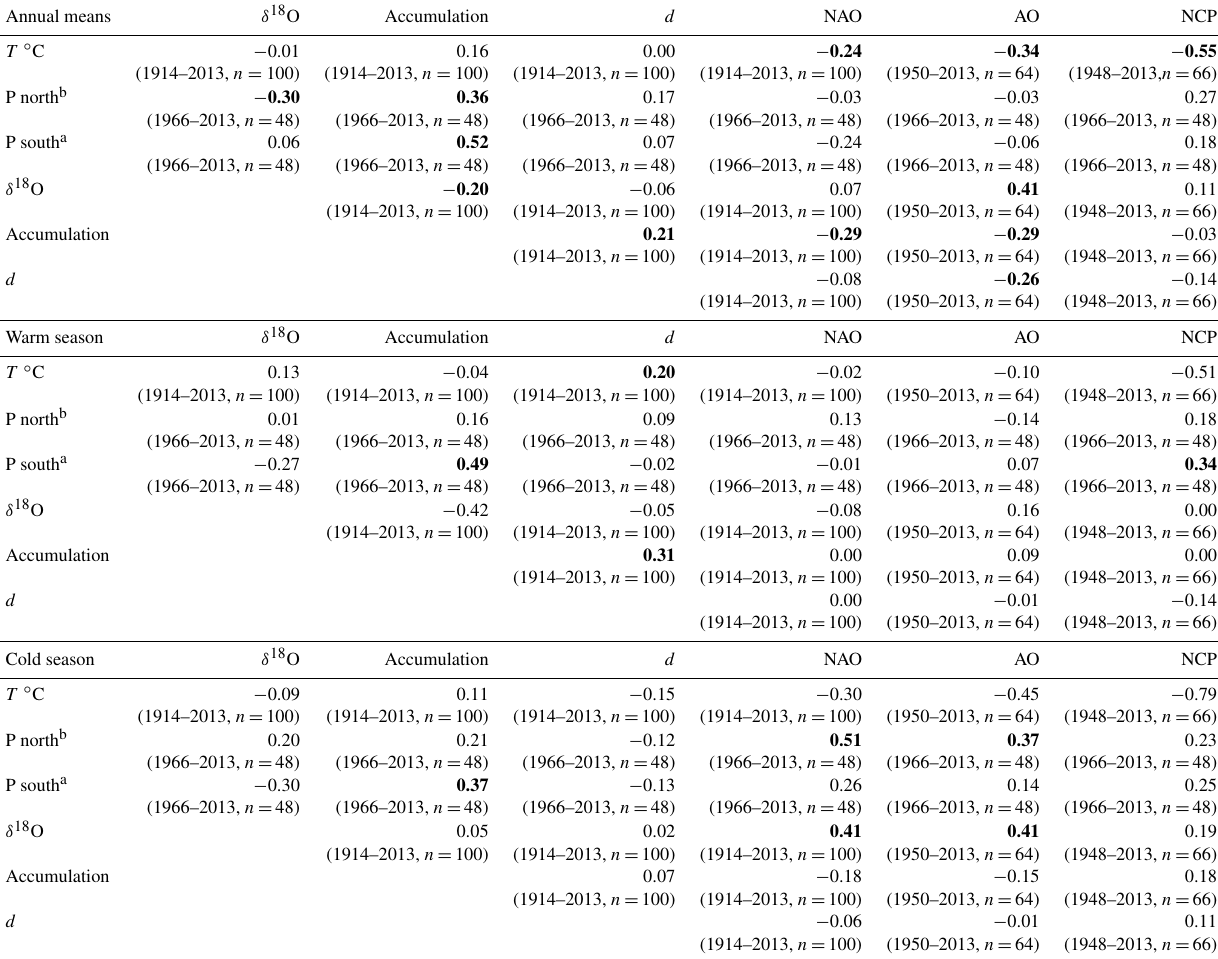
Table 4. Correlation coefficients between ice core data, meteorological data, and indices of large-scale modes of variability (statistically significant coefficients at p < 0 . 05 are highlighted in bold). The period of calculation and number of data points ( n ) for each coefficient is shown in